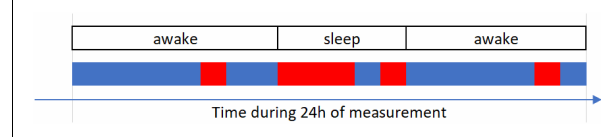
FIGURE 7 | Conceptual (illustrative) representation of the classification of segments. Red and blue lines represent sleep and awake stages, respectively, obtained via our classification. Self-reported information is indicated in boxes. Actual sleep and awake stages overlap only partially with the stages as reported by the